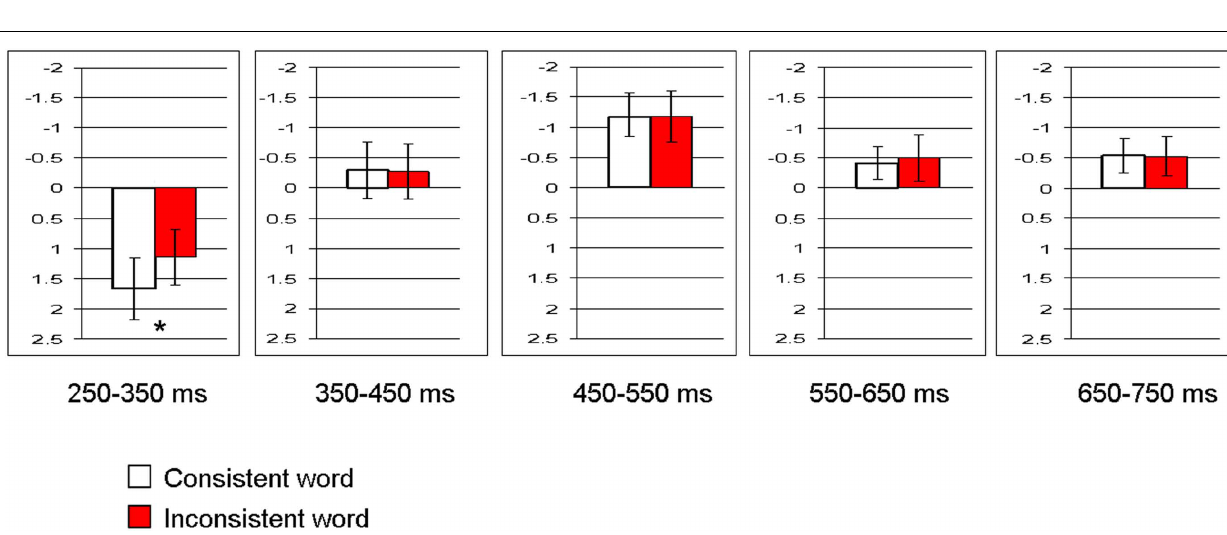
FIGURE 3 | Mean amplitudes ( μ V) and standard errors or SEs within each time window for electrodes within the left centro-posterior